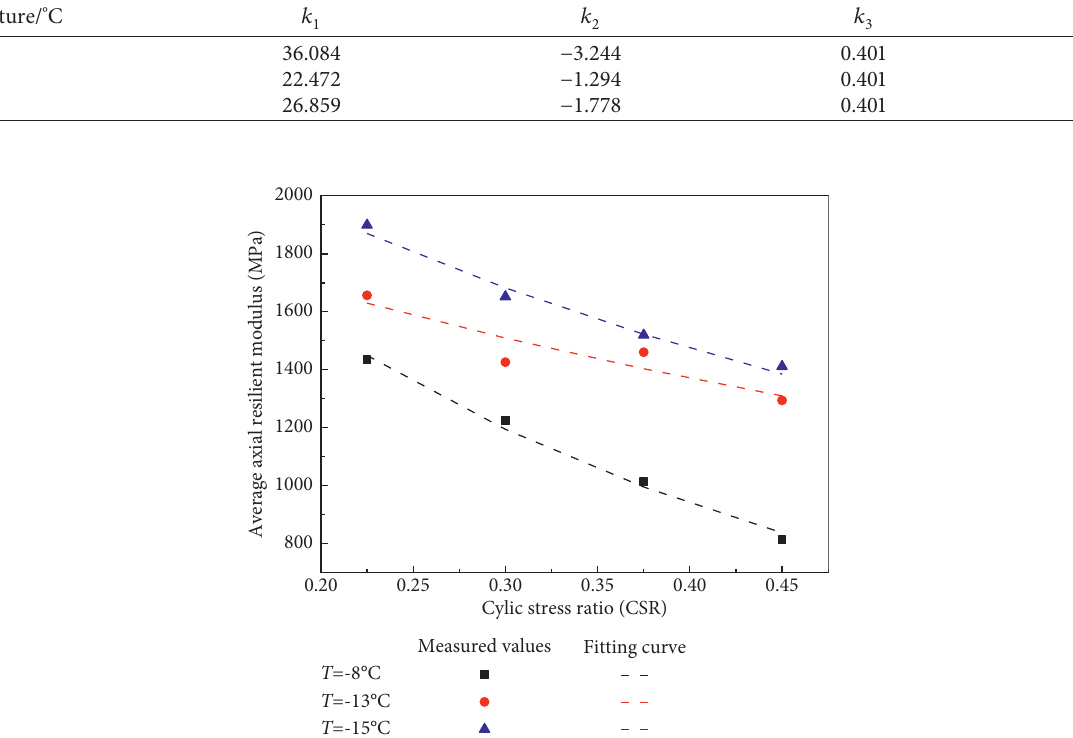
Figure 17: Comparison of optimal fitting curves and measured average axial resilient modulus under different